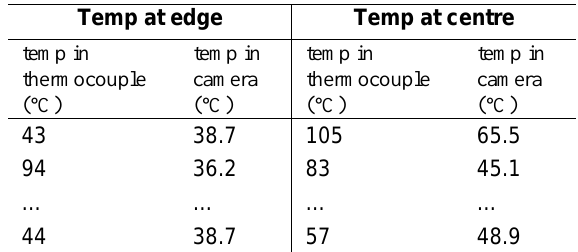
Table 1 . Comparative temperature reading between